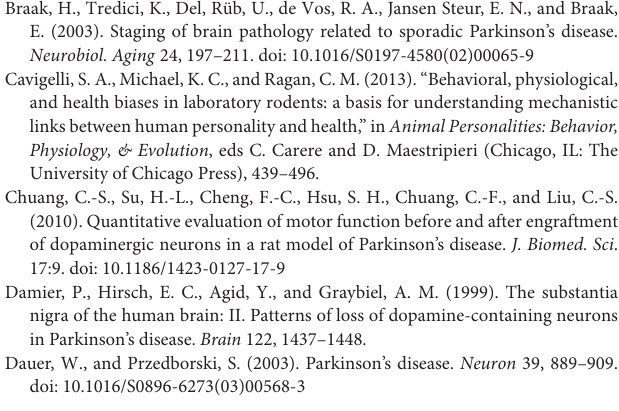
TABLE 2 | Correlation of motor deficits with the number of tyrosine hydroxylase positive neurons in the substantia nigra in the MFB lesion cohort and MFB sham cohort 6 weeks after lesioning. P -value Parameter Pearson correlation Parameter Pearson correlation coefficient